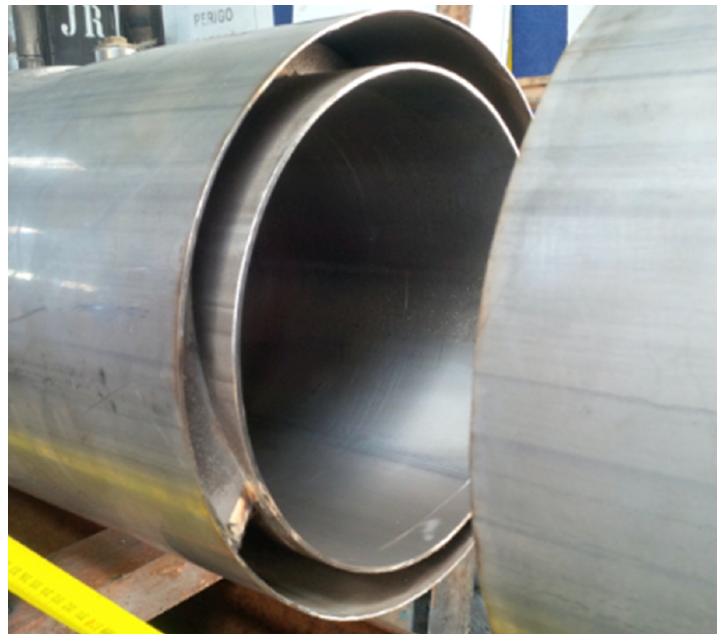
Figure 8. Cut of one of the double-walled augers of the cooling system, in which the chamber where the cooling water circulates is visible. The heat is dissipated by conduction through the cooled walls of the auger in contact with the material that circulates inside.